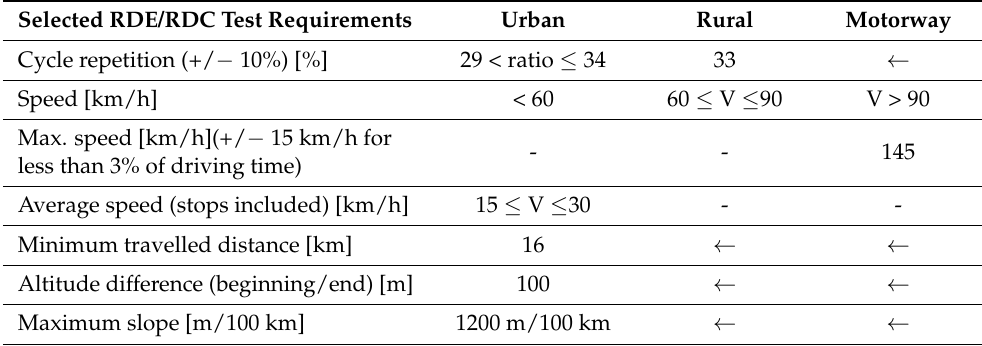
Figure 11. Route driven during the examinations.